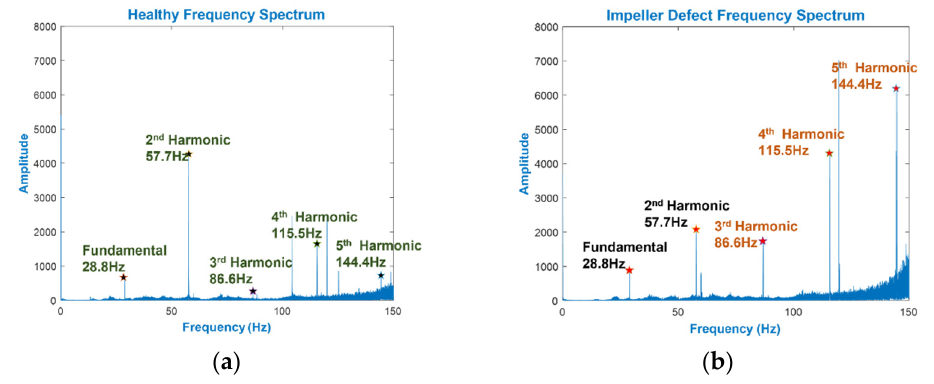
Figure 6. MCP spectrum of ( a ) NC, and ( b ) ID.